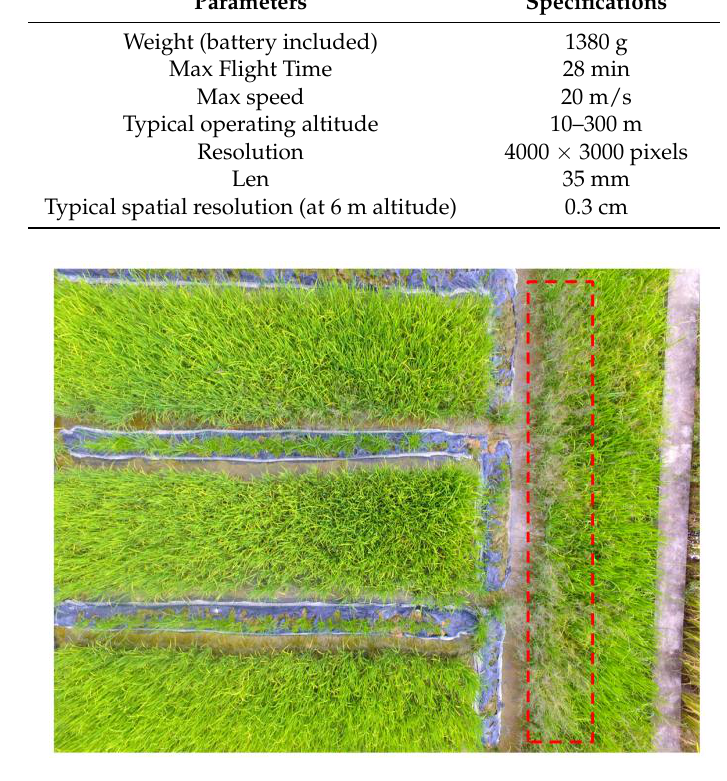
Figure 3. An example of the UAV imagery collected in the experiment.